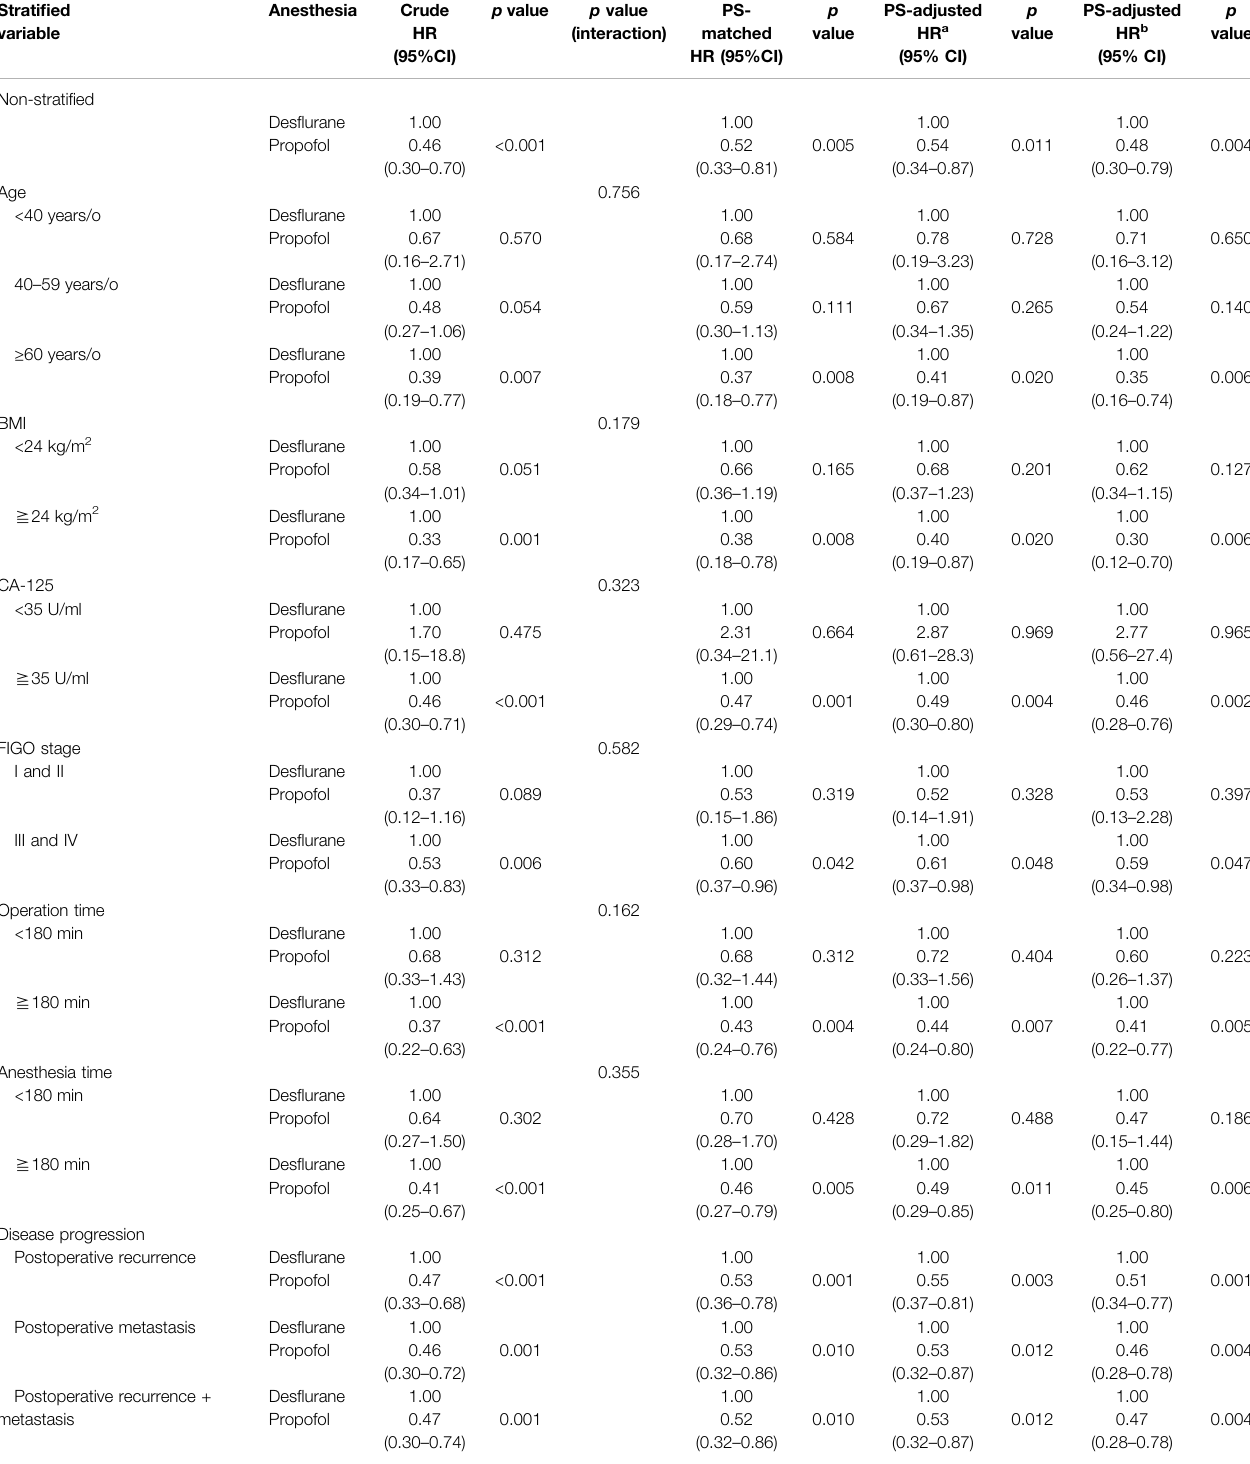
TABLE 3 | Subgroup analyses for age, BMI, CA-125 level, FIGO stage, operation and anesthesia time, and disease